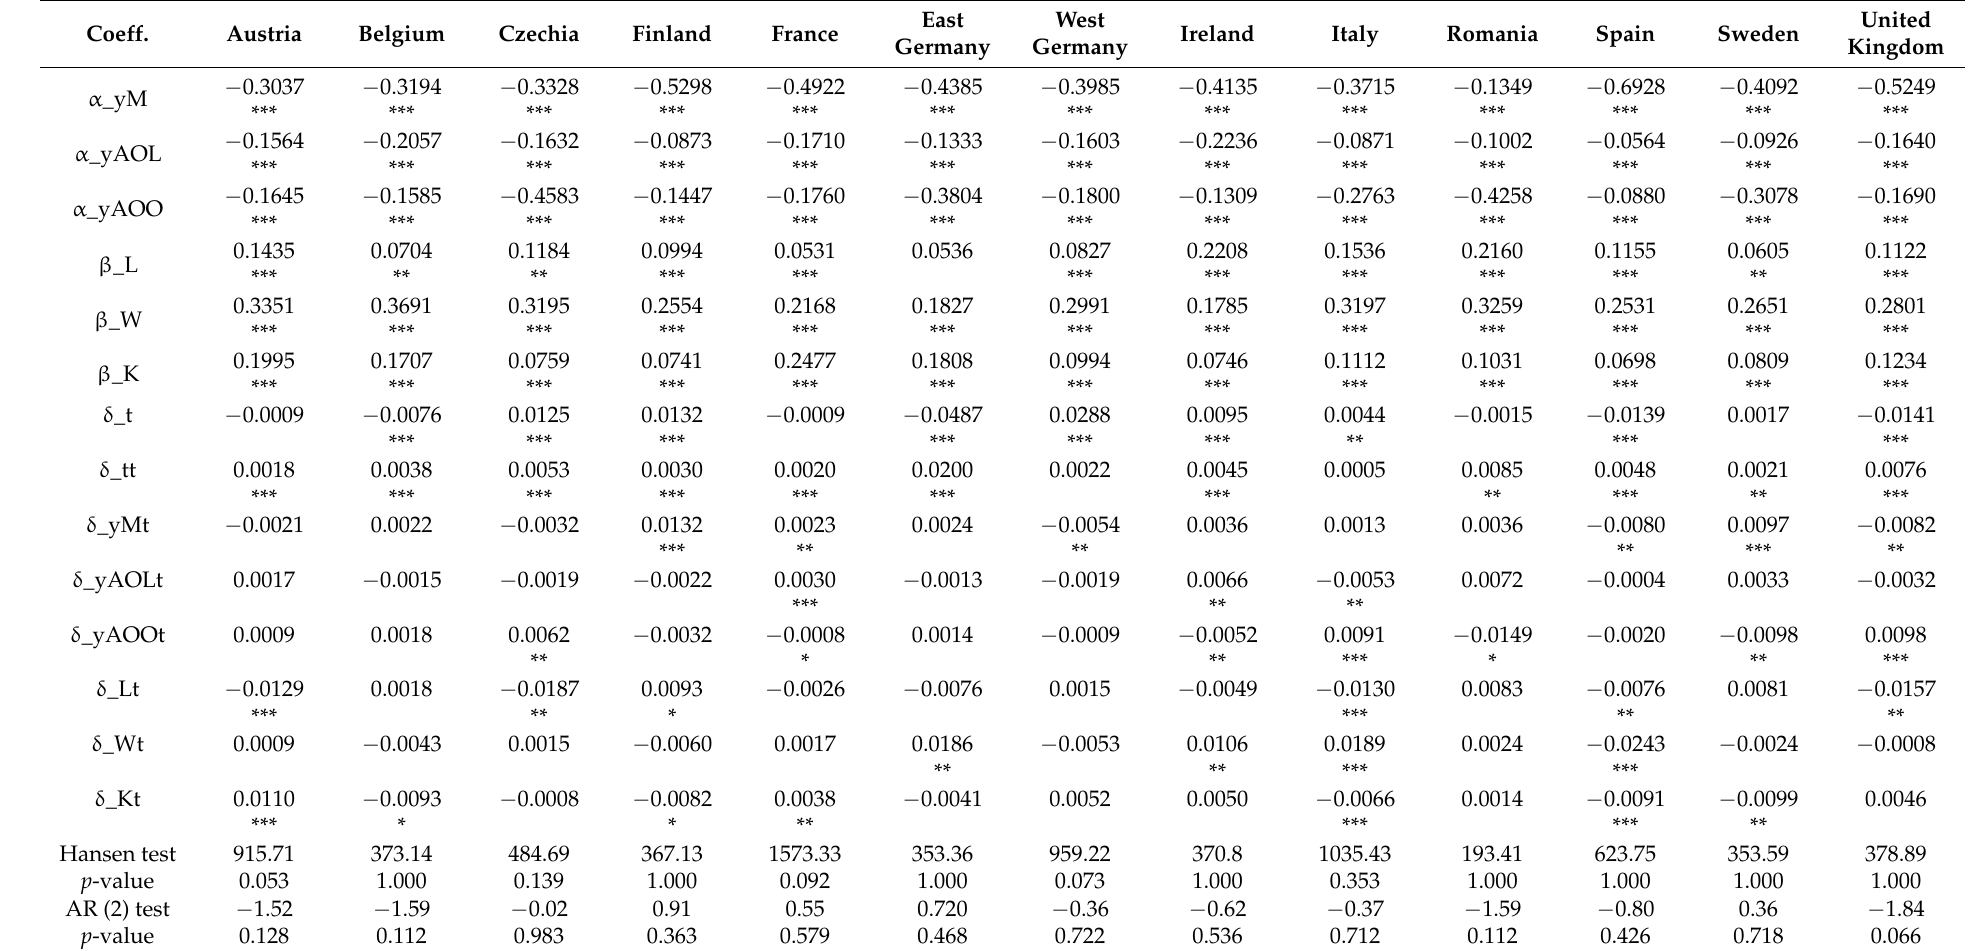
Table 3. First-order parameters, technological change parameters, and tests of IDFs. Source: authors’ own calculations.